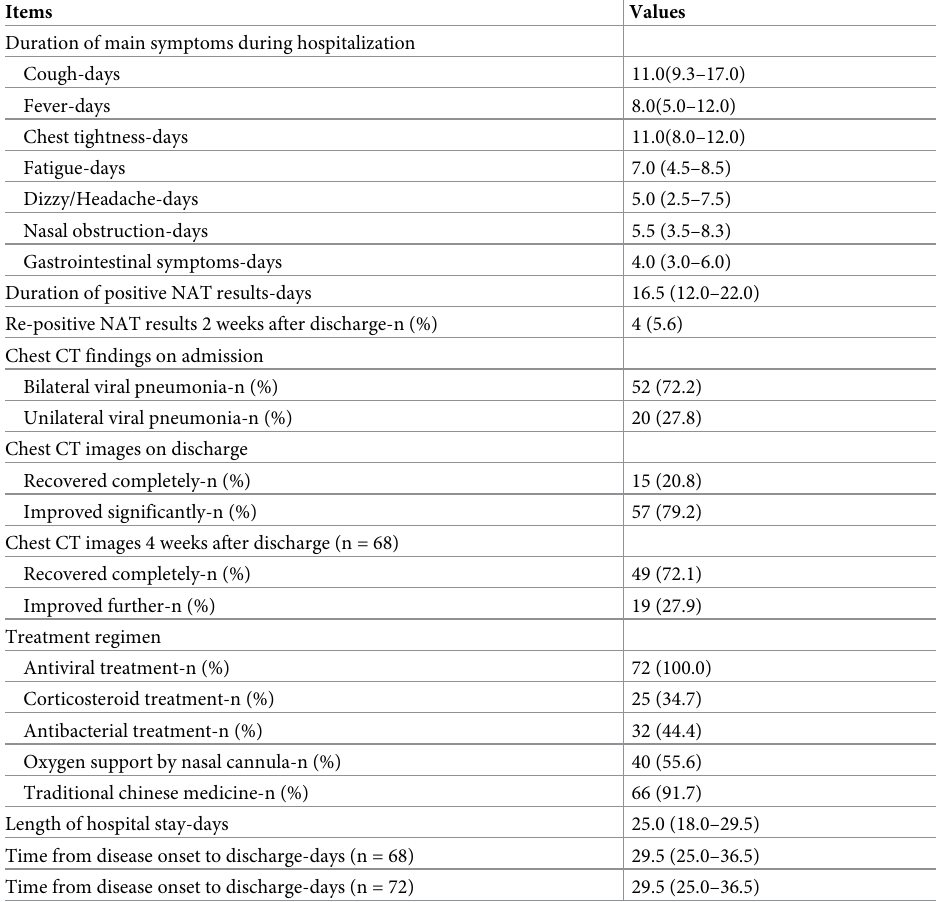
Table 1. Clinical course and follow-up outcome of 72 moderate survivors with COVID-19.